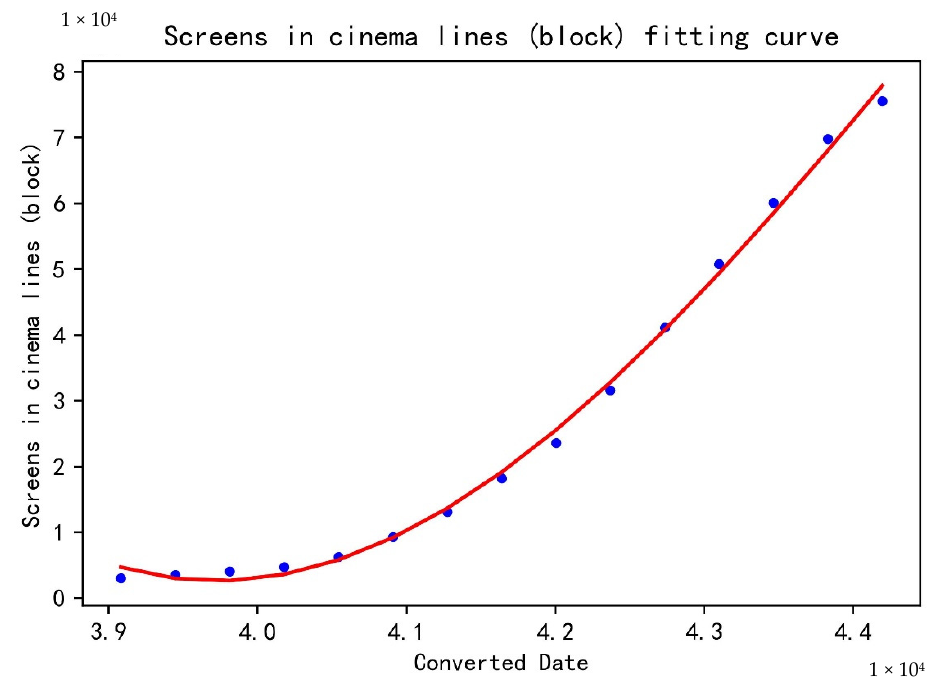
Figure 2. Screens in cinema lines (block) fitting curve.